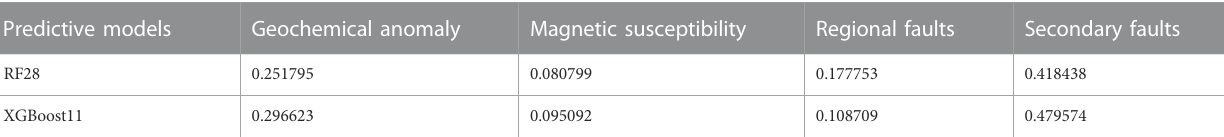
TABLE 6 The spatial associations between targets and exploration criteria re fl ected by the impurity of the RF28 and XGBoost11 predictive models. Predictive